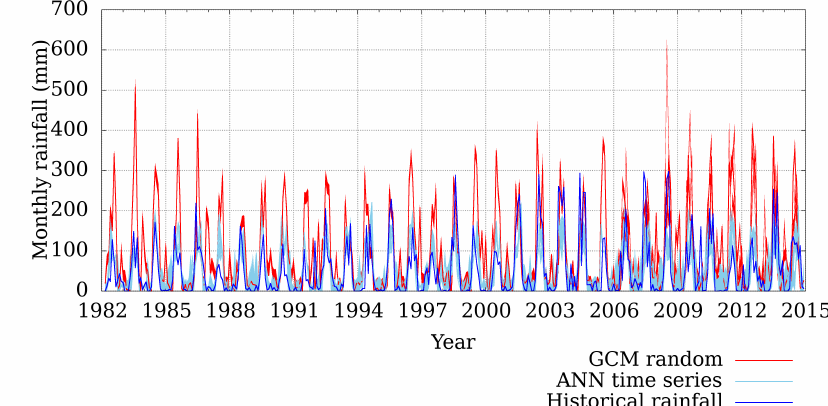
Figure 7. Results of the Monte Carlo simulation for random generator 2 (rain gauge: 11,020).